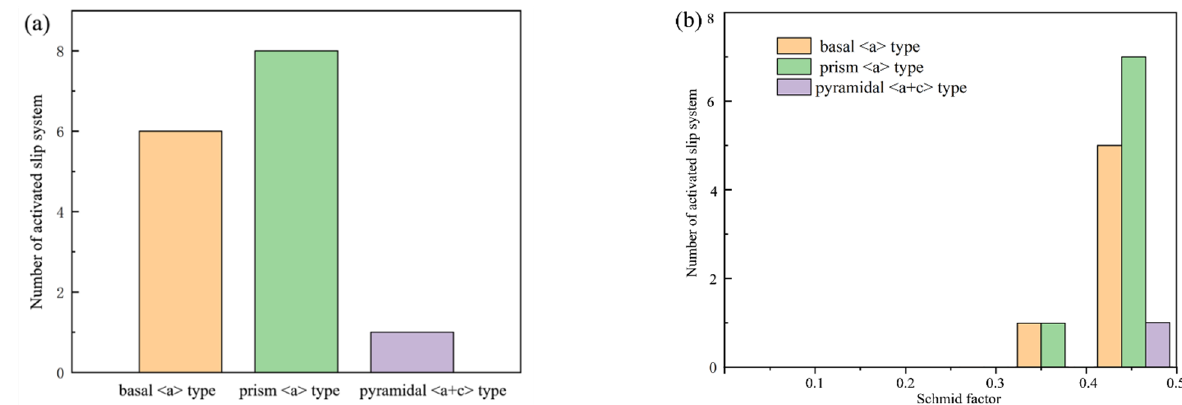
Figure 10. The activated slip systems of α 2 particles ( a ) number of slip systems; ( b ) distribution of SF in different slip systems.